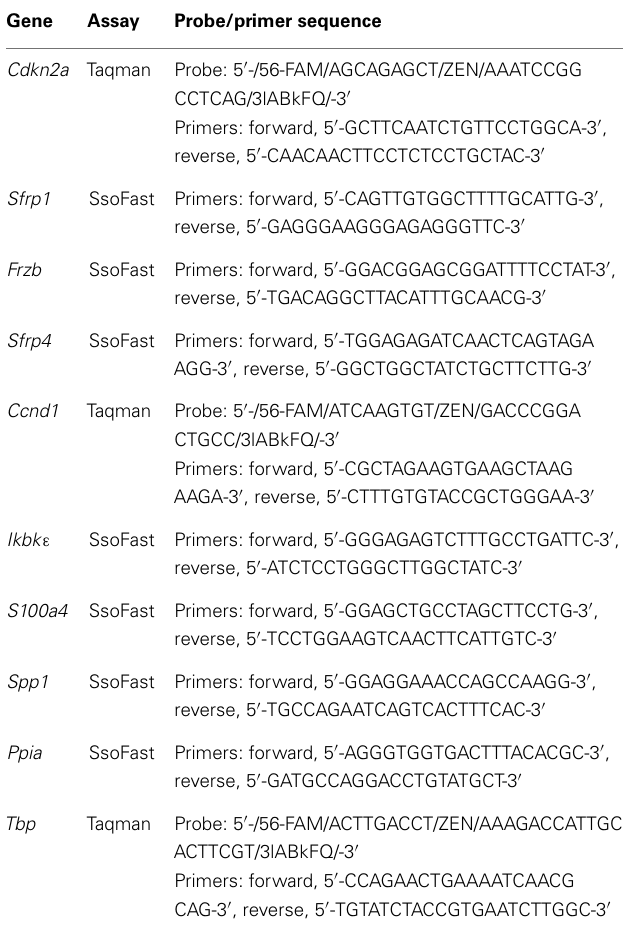
Table 1 | Quantitative RT-PCR probe and primer